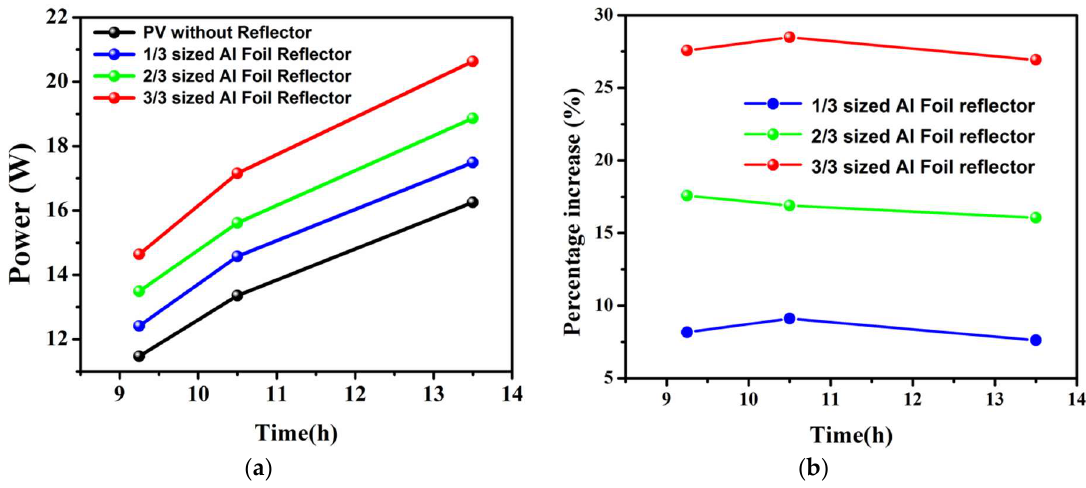
Figure 14. Finding optimal size of reflector: ( a ) Output power; ( b )Percentage increase.